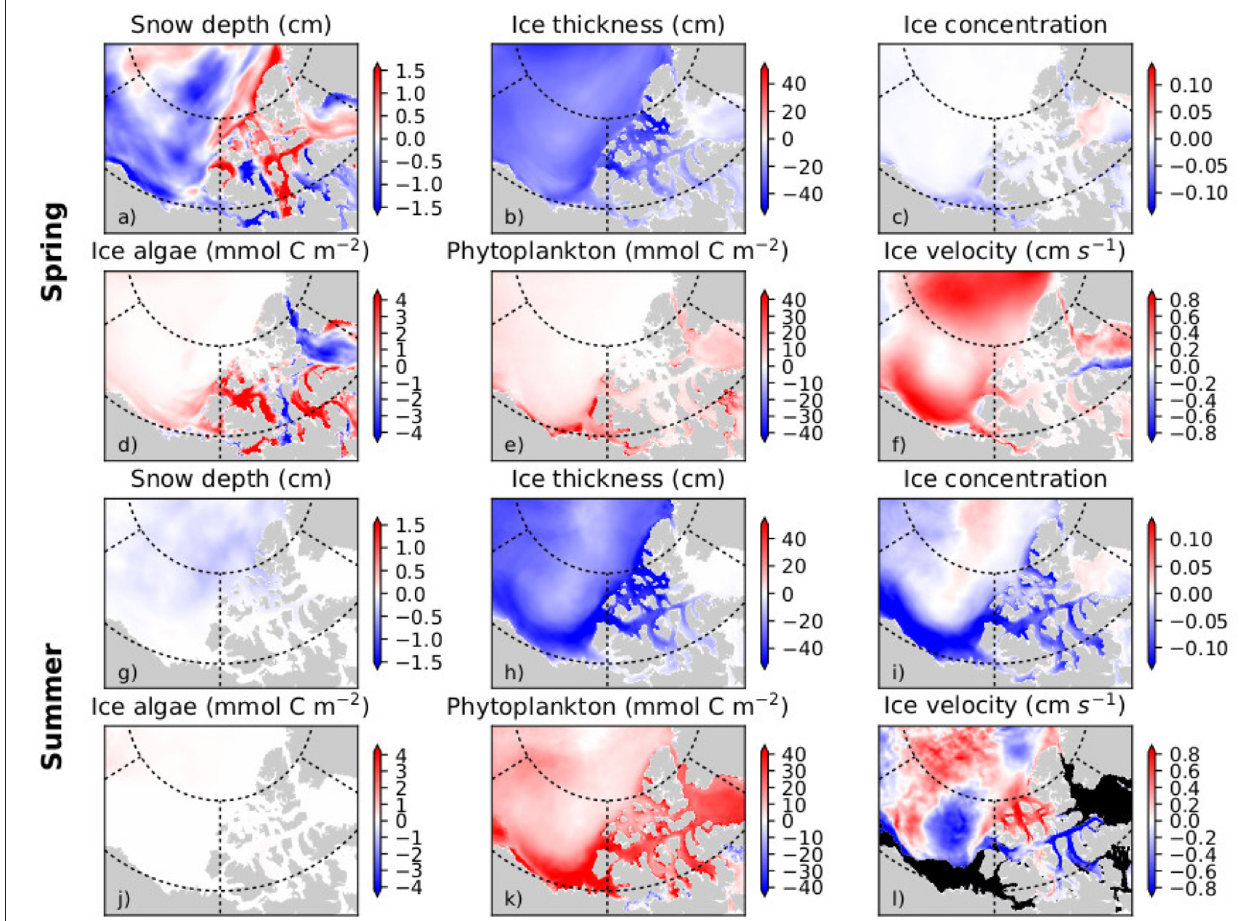
FIGURE 4 | Mean trend (per decade) in the spring (April-June; a–f ) and summer (July-September; g–l ) for snow depth, ice thickness, ice concentration, ice algal biomass, phytoplankton biomass, and ice velocity in the Western Canadian Arctic over the period 1979–2015 as simulated with the regional high resolution model